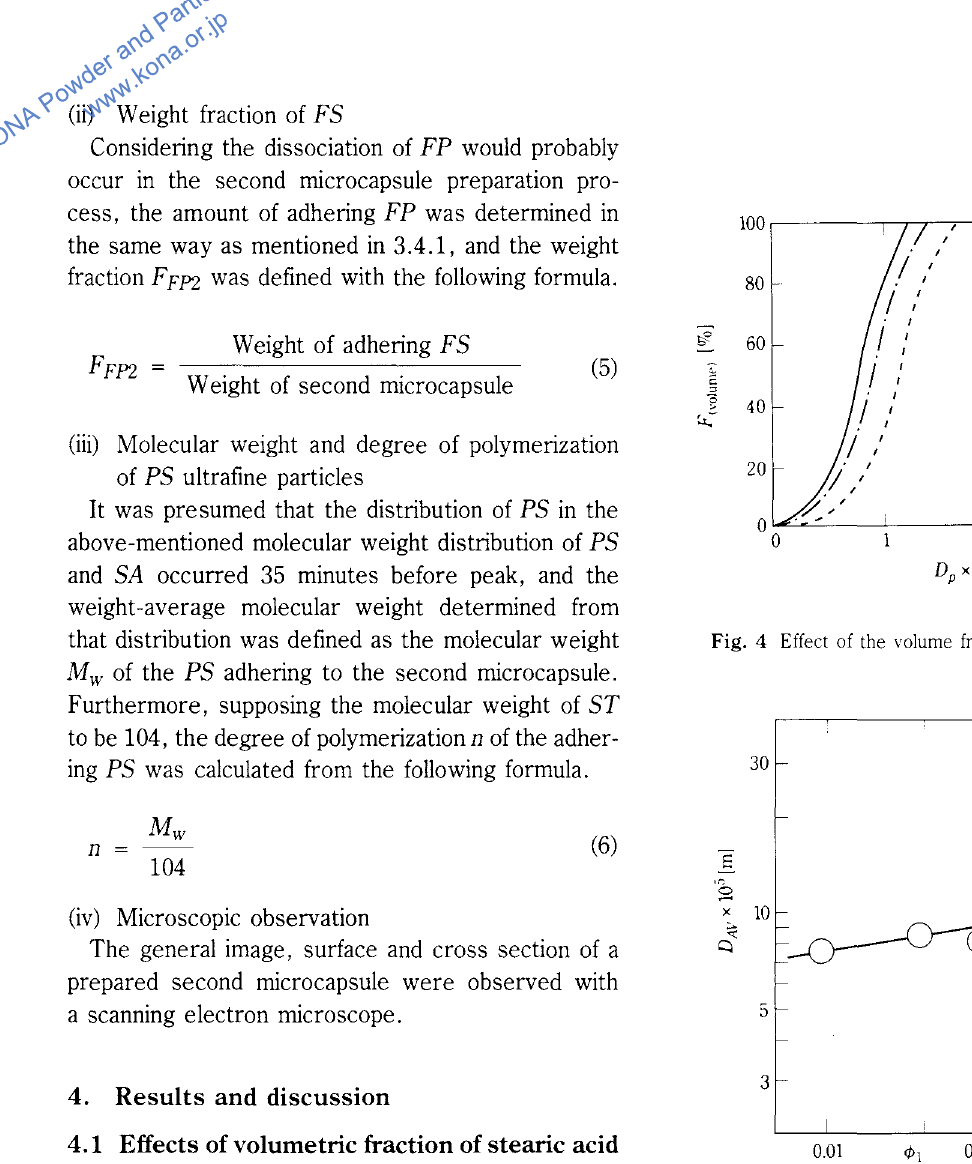
Fig. 5 Effect of the volume fraction on the mean size